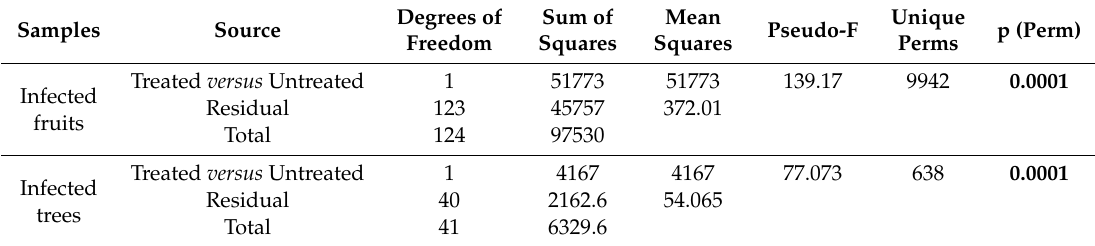
Table 2. Details of the one-factor PERMANOVA dataset test on the number of fruits and number of trees positive to Colletotrichum spp. for the factor; management regime “Treated and Untreated” (1 level, fixed) for the variables